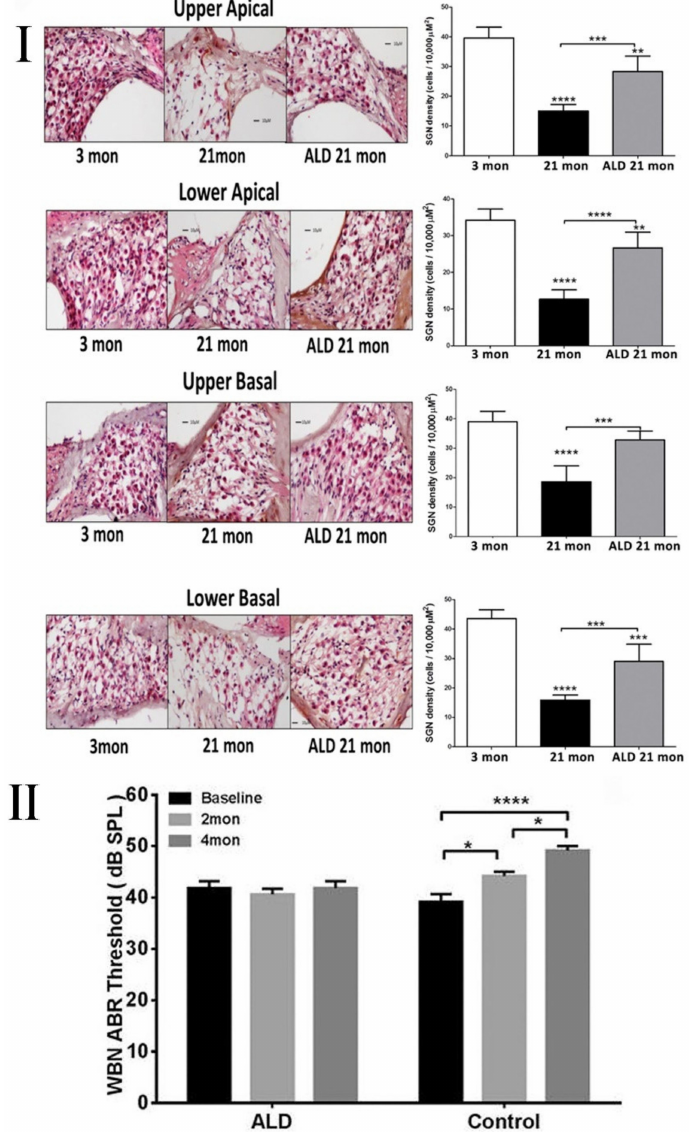
Figure 5. Protective effects of aldosterone treatment on SGN and ABR thresholds. ( I ) Spiral ganglion neuron (SGN) counts between young adult mice (left panel), middle-aged mice without aldosterone treatment (21 months, middle panel), and middle-aged mice with aldosterone treatment (21 months, right panel) show treated animals having higher SGN densities compared to nontreated